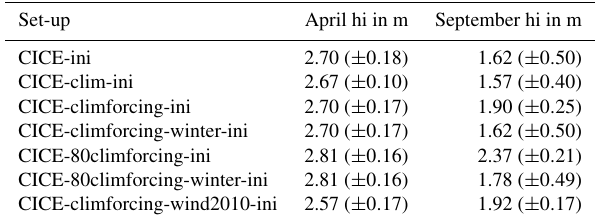
Table 5. Impact of initial November sea ice conditions and atmo- spheric forcing on the mean sea ice thickness (hi) of subsequent April and September over the region shown in Fig. 3 from 2011 to 2017. See Sect. 3.3 for explanation of CICE simulations. Inter- annual variability is given in